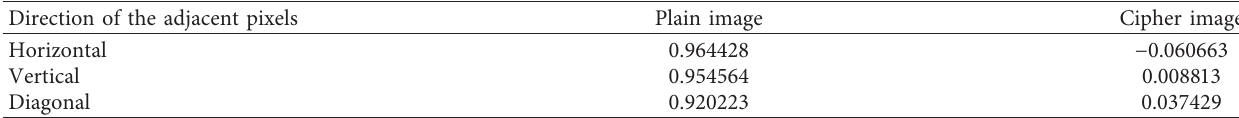
Figure 8: The distribution of two adjacent pixels. w and h denote the abscissa and the ordinate of the pixels. (a–c) The distribution of two horizontally, vertically, and diagonally adjacent pixels selected in the plain image. (d–f) The distribution of two horizontally, vertically, and diagonally adjacent pixels selected in the cipher image. Table 1: Pearson’s correlation coefficient of adjacent